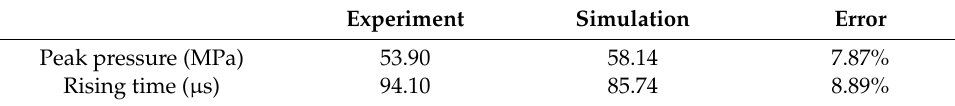
( b ) Figure 7. Finite element model of propellant actuator: ( a ) external view, ( b ) internal view. In this paper, the single-point integration algorithm was selected as the simulation algorithm of the numerical calculation model on account of its relatively high efficiency and accurate calculation accuracy. Meanwhile, contact surface-to-surface was chosen as the contact algorithm between the different parts. Moreover, the material adopted for all components of propellant actuator was 1Cr18Ni9Ti with a constitutive relationship plas- tic_kinematic, and the main constitutive parameters are shown in Table 3. Table 3. Main constitutive parameters [23]. Material